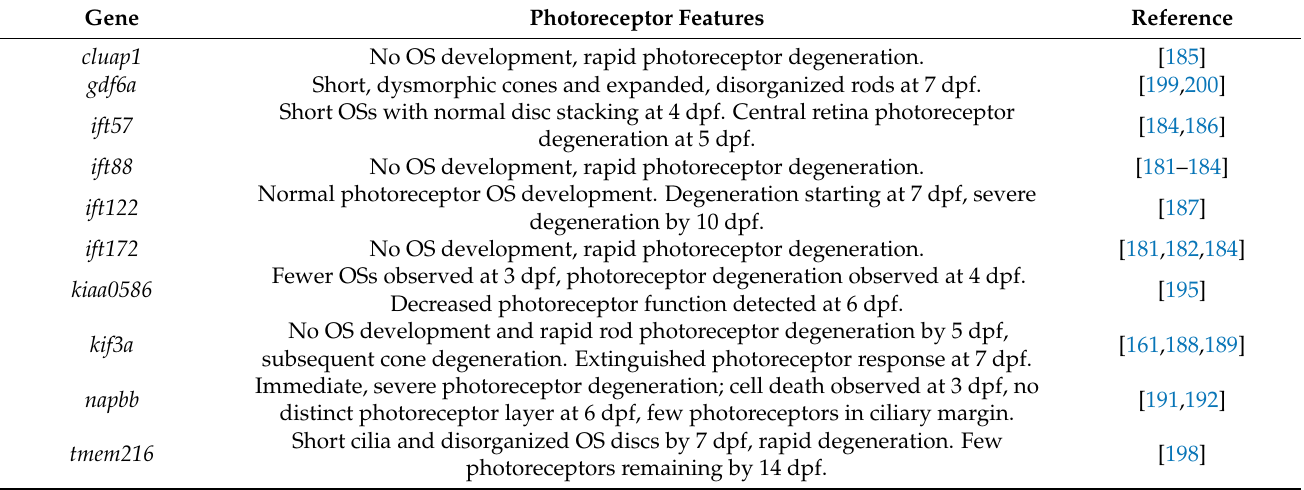
Table 5. Zebrafish mutant models of Leber congenital amaurosis-like photoreceptor disease. Gene Photoreceptor Features